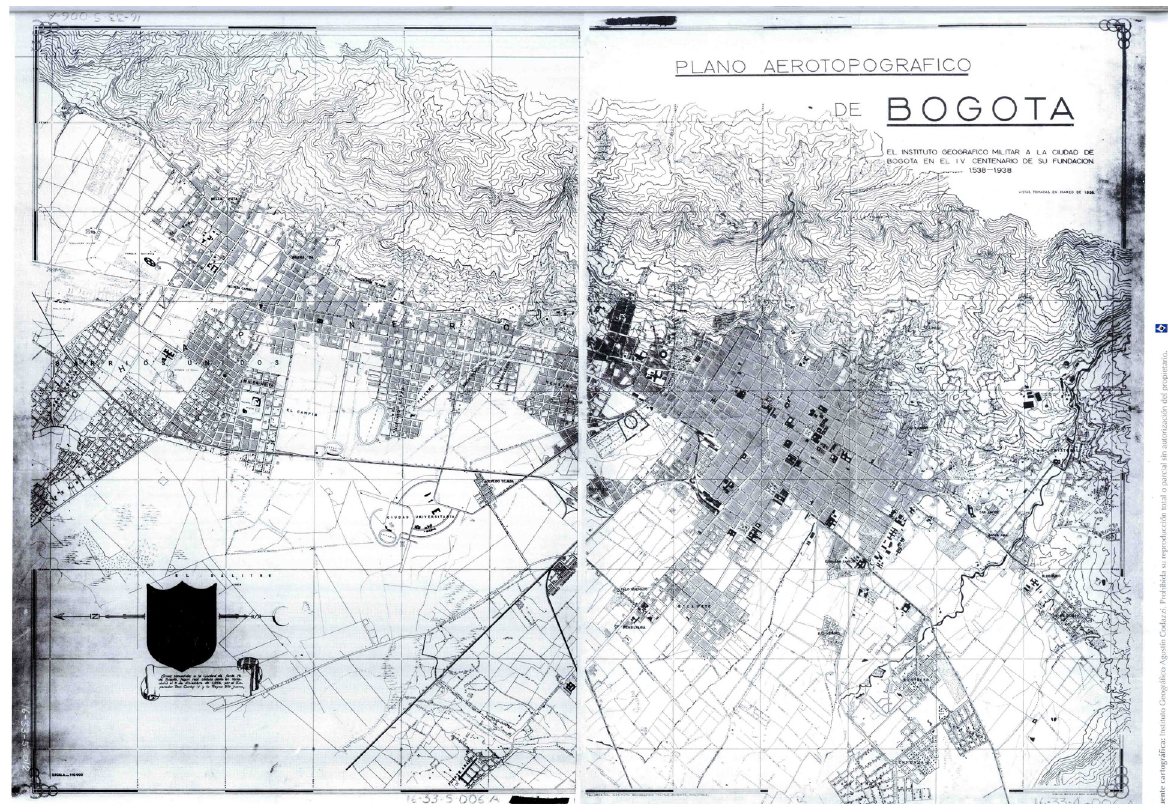
Figure 6. Aero topographic map of Bogotá. Military Geographic Institute (1938). Source: (Cuéllar Sánchez & Mejía Pavony 2007, p.